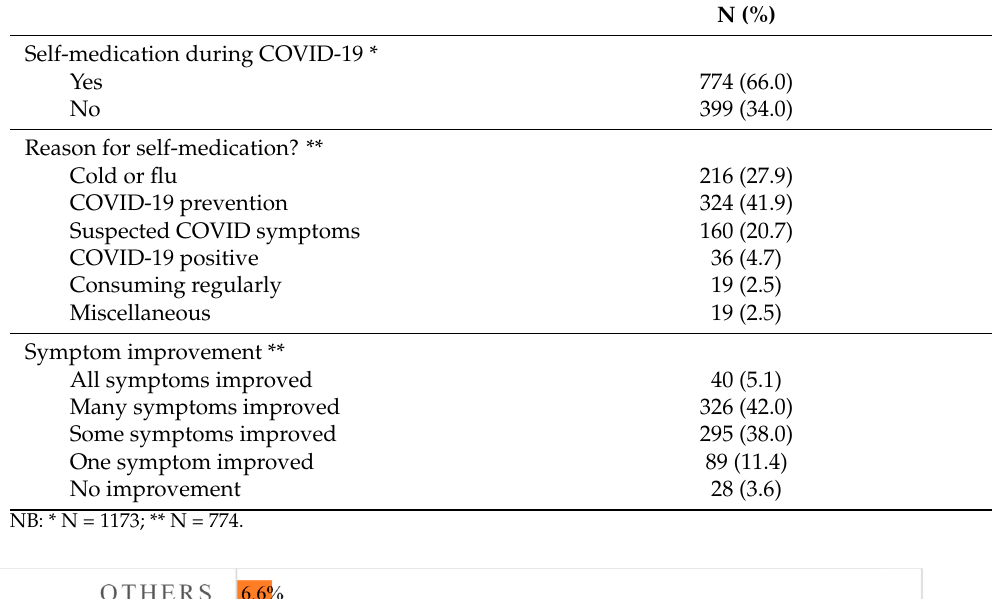
Table 4. Respondents’ practices related to self-medication amid the COVID pandemic.